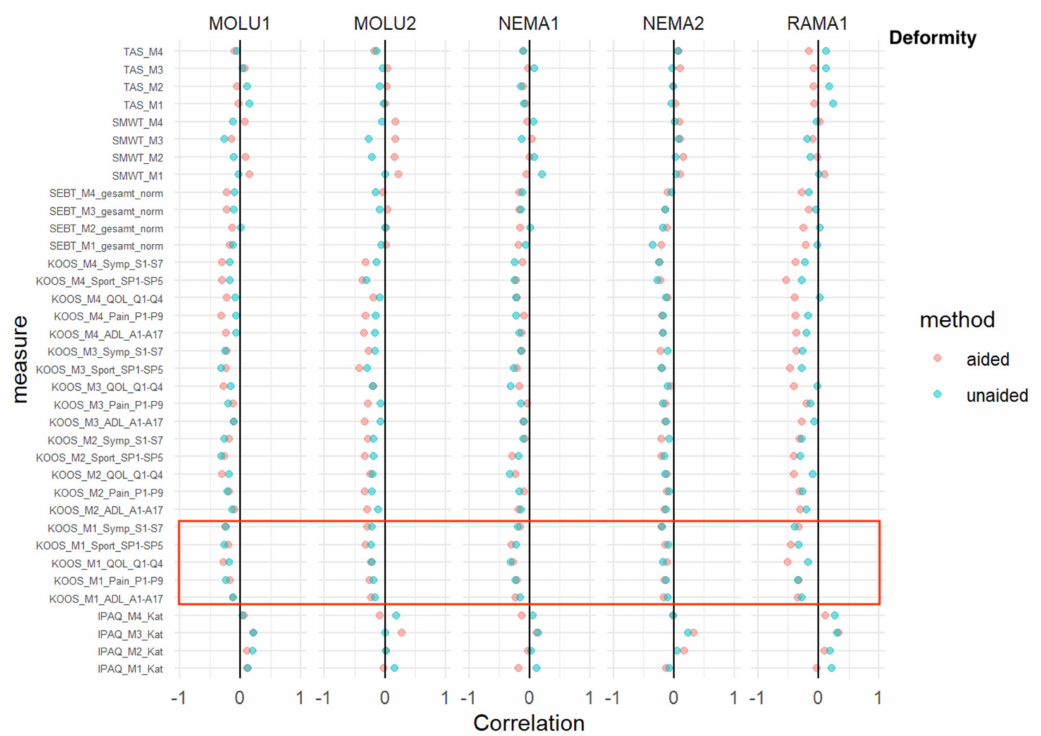
Figure 7. Deformity —correlation analysis for AI-aided (red dots) versus AI-unaided (green dots) readings with clinical scores. Red square marks all baseline KOOS scores